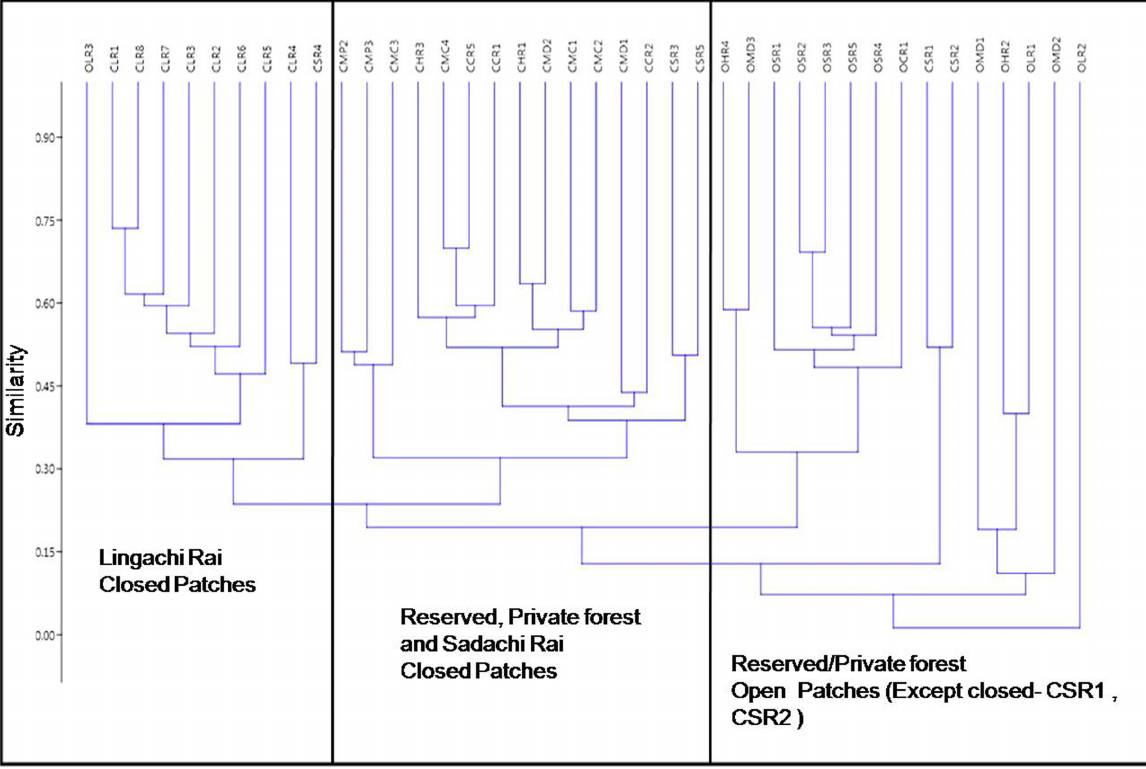
study area and compares it with similar such studies conducted elsewhere inside PAs and reserve forests of